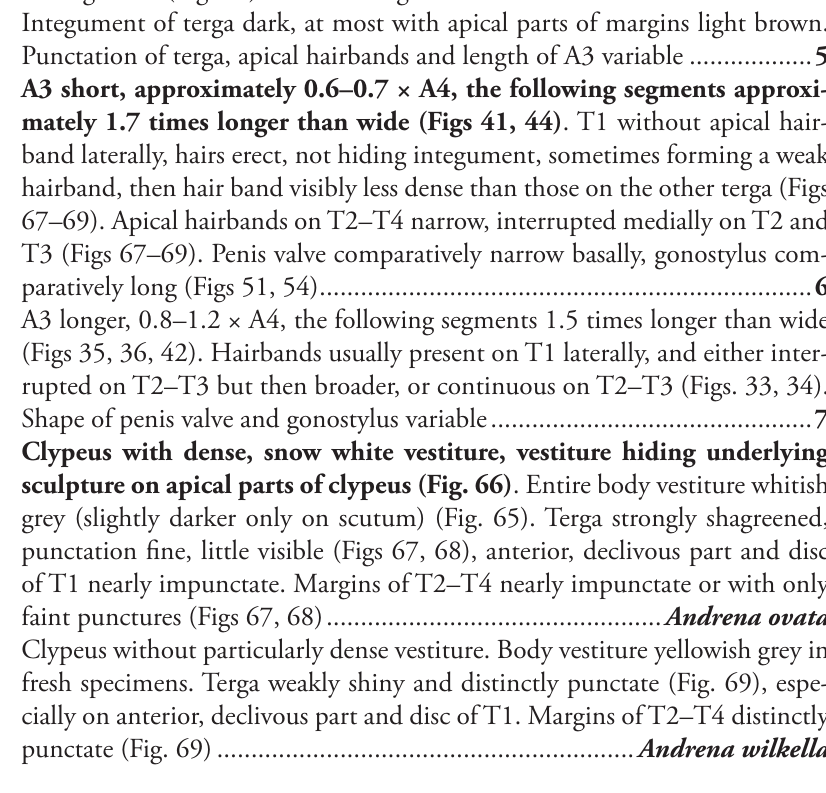
Figs 69, 70). Terga not visibly impressed basally, disc evenly flattened. Width of valve and opening between internal margins of gonocoxae variable ......... 2 2 Valve basally broad, its maximal width approximately equal to 2 diameters of lateral ocellus (Figs 49, 50). Opening between internal margins of gono- coxae comparatively large, margins adjacent basally and abruptly divergent apically ....................................................................................................... 3 – Valve basally less broad, its width at most 1.5 × diameters of lateral ocellus (Figs 45–48, 51, 52, 54). Opening between internal margins of gonocoxae smaller, margin less strongly and abruptly divergent.................................... 4 3 Valve basally approximately as wide as maximal width of gonostylus (Fig. 50). Opening of valve very wide, wider than surface of median ocellus (Fig. 50) . Antennal segment 3 0.8–1.0 × A4 (Fig. 40) ........... Andrena intermedia – Valve less wide than maximal width of gonostylus (Fig. 49). Opening of valve much smaller than surface of median ocellus (Fig. 49). A3 shorter, approxi- mately 0.6 × A4 (Fig. 39) .................................................... Andrena gelriae 4 Integument of terga partly orange brown, especially margins, pregradu- lar area and lateral, declivous parts . Tergal discs very faintly punctate, punc- tures little visible in shagreenation. Terga with comparatively narrow apical hairbands laterally, hairbands broadly interrupted on all terga. A3 0.7–0–8× as long as A4 (Fig. 38). Genitalia Fig. 48 ................... Andrena croceiventris – Integument of terga dark, at most with apical parts of margins light brown. Punctation of terga, apical hairbands and length of A3 variable .................. 5 5 A3 short, approximately 0.6–0.7 × A4, the following segments approxi- mately 1.7 times longer than wide (Figs 41, 44) . T1 without apical hair- band laterally, hairs erect, not hiding integument, sometimes forming a weak hairband, then hair band visibly less dense than those on the other terga (Figs 67–69). Apical hairbands on T2–T4 narrow, interrupted medially on T2 and T3 (Figs 67–69). Penis valve comparatively narrow basally, gonostylus com- paratively long (Figs 51, 54) ........................................................................ 6 – A3 longer, 0.8–1.2 × A4, the following segments 1.5 times longer than wide (Figs 35, 36, 42). Hairbands usually present on T1 laterally, and either inter- rupted on T2–T3 but then broader, or continuous on T2–T3 (Figs. 33, 34). Shape of penis valve and gonostylus variable ............................................... 7 6 Clypeus with dense, snow white vestiture, vestiture hiding underlying sculpture on apical parts of clypeus (Fig. 66) . Entire body vestiture whitish grey (slightly darker only on scutum) (Fig. 65). Terga strongly shagreened, punctation fine, little visible (Figs 67, 68), anterior, declivous part and disc of T1 nearly impunctate. Margins of T2–T4 nearly impunctate or with only faint punctures (Figs 67, 68) ................................................. Andrena ovata – Clypeus without particularly dense vestiture. Body vestiture yellowish grey in fresh specimens. Terga weakly shiny and distinctly punctate (Fig. 69), espe- cially on anterior, declivous part and disc of T1. Margins of T2–T4 distinctly punctate (Fig. 69) ............................................................. Andrena